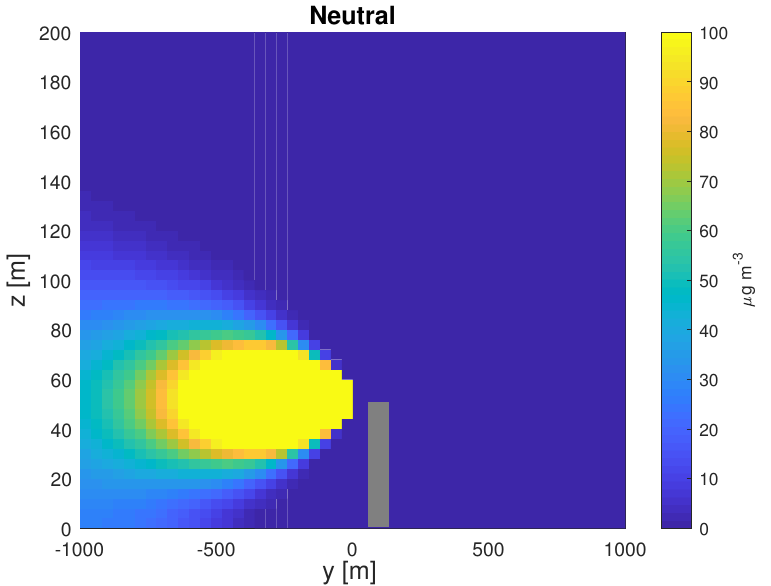
Figure 7. The 2D Gaussian pollutant concentration dispersion model in a plume for the neutral stability situation. The gray bar represents the effective height of the emission